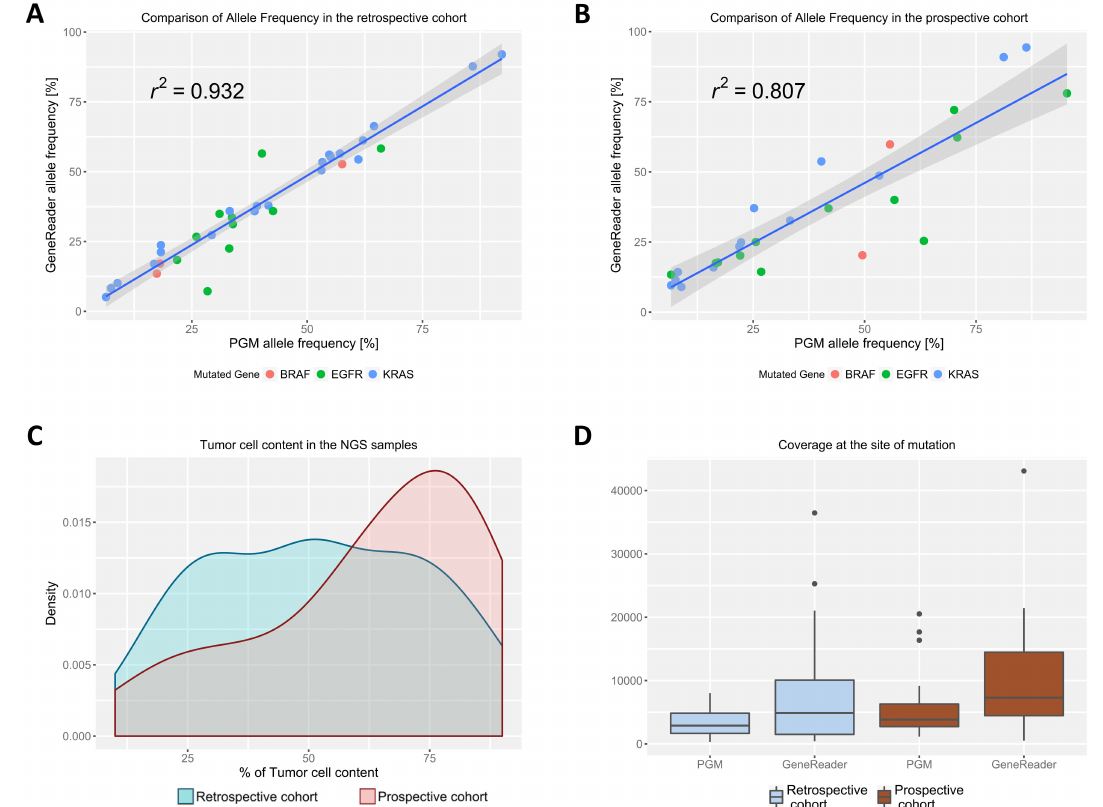
Figure 1. Correlation of the allele frequency for all mutations found between the GeneReader and the Ion PGM in the ( A ) retrospective and the ( B ) prospective cohort. The Pearson’s correlation is indicated on the graphs. The 95% confidence interval is represented as hatched grey areas. The different underlying mutations are indicated by differently colored dots on the plot; ( C ) Density plot of tumor-cell content distribution between the retrospective (in blue) and prospective cohort (in red); ( D ) Coverage at the site of mutation in the respective genes for the GeneReader and the Ion PGM. Median with the first and third quartile is blotted in the boxes, prolonged with the 1.5 × interquartile range. Outliers outside of this range are indicated as